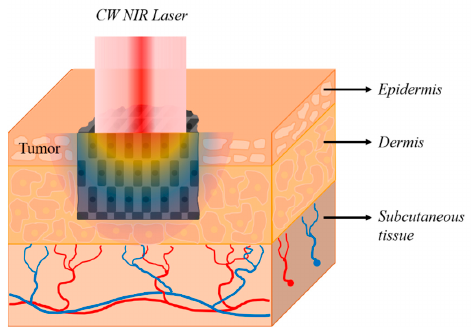
Figure 1. A schematic of photothermal therapy for skin tissue.